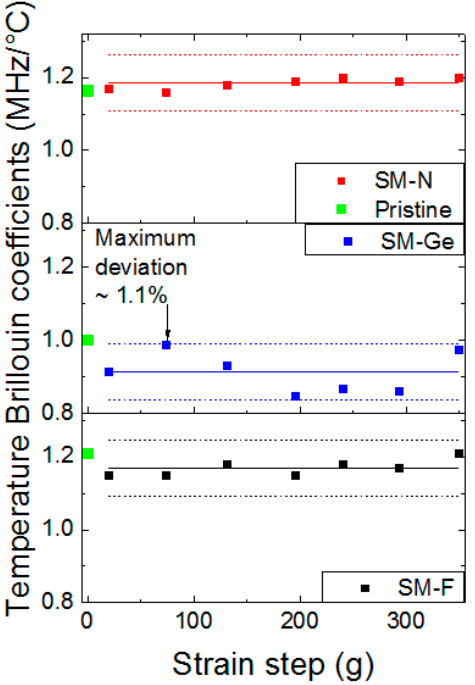
Figure 11. Brillouin central frequency ( a ) and Rayleigh relative spectral shift ( b ) evolutions as a function of temperature after irradiation at a dose of 56 kGy for the F-doped, Ge-doped and N-doped samples.